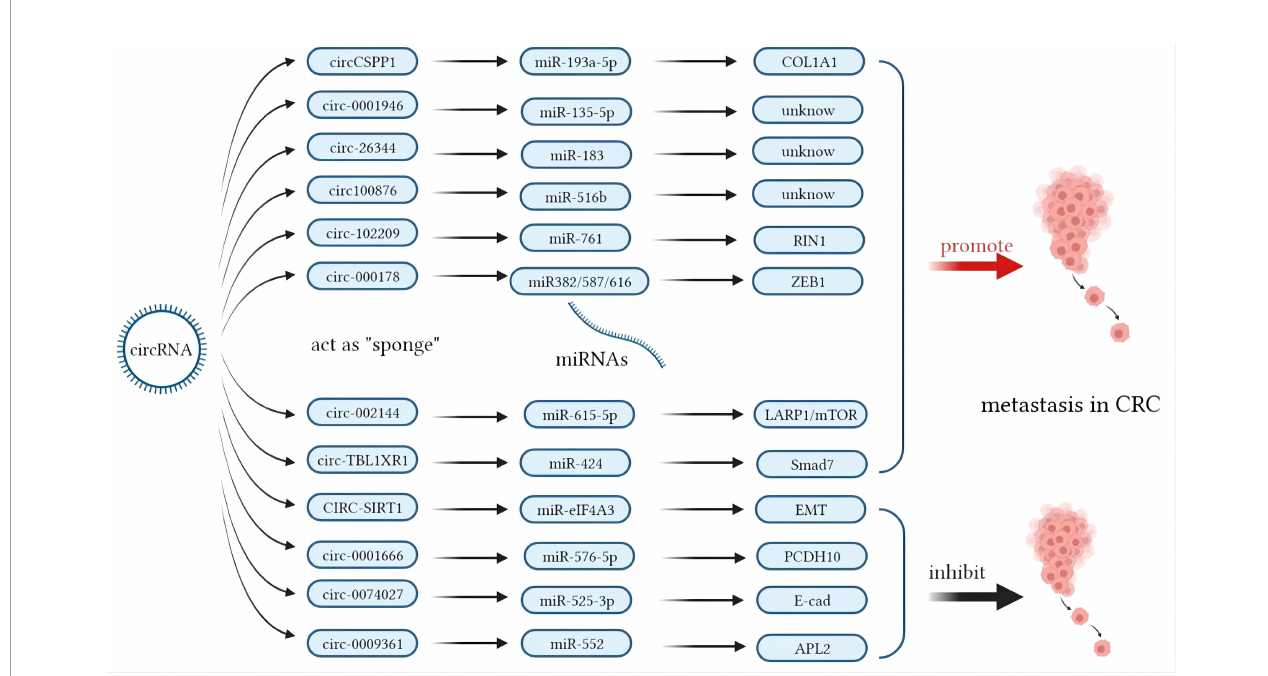
FIGURE 2 | Mechanisms of circular RNAs (circRNAs) acting as competing endogenous RNAs (ceRNAs) in colorectal cancer (CRC)